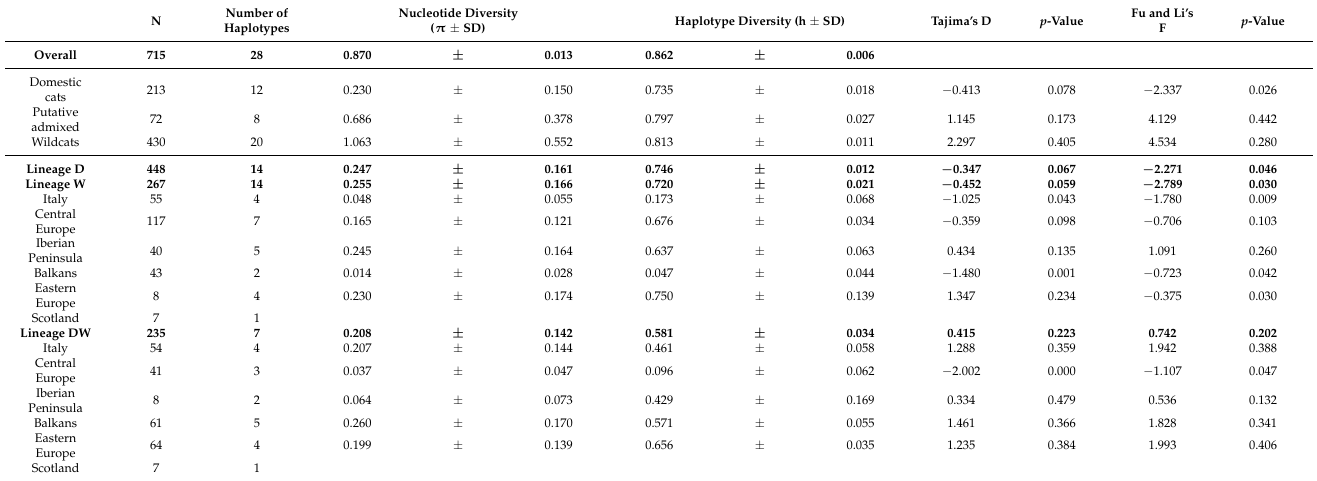
Table 1. Summary of genetic variability statistics obtained by analyzing a portion of the mitochondrial ND5 gene and considering as sample groups: (a) STR Bayesian assignment cat populations [25]; (b) main phylogenetic lineages; and (c) biogeographic macro-regions within each phylogenetic lineage. For lineages W and DW (lineage D pruned by domestic cats), the statistics are also provided for each macro-region. N = number of samples; SD = standard